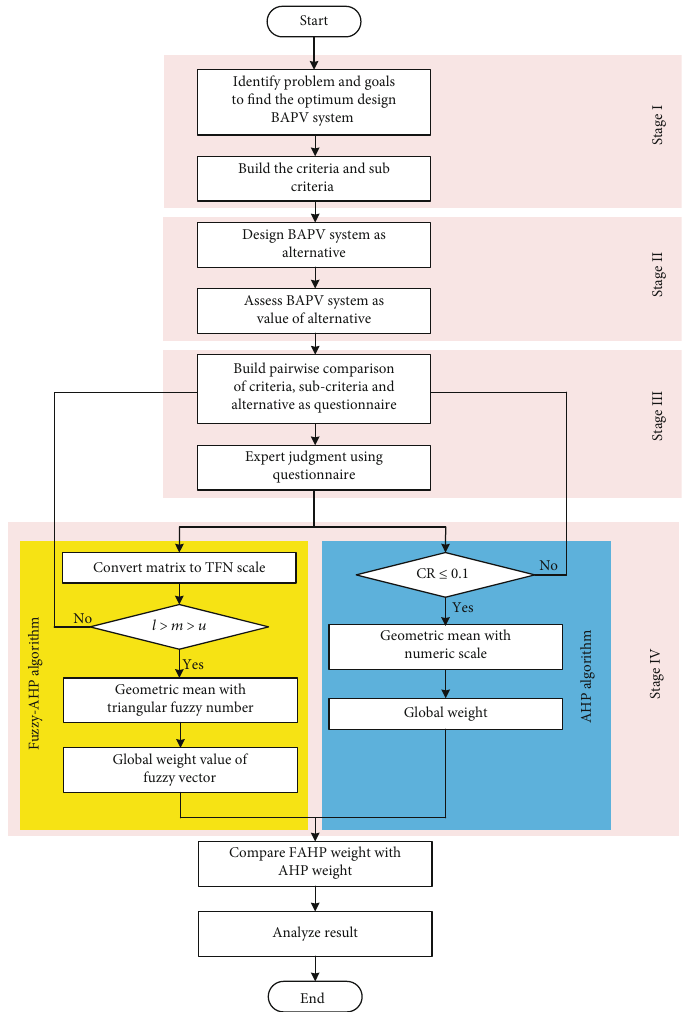
Figure 6: Hierarchy for fuzzy AHP in BAPV system.